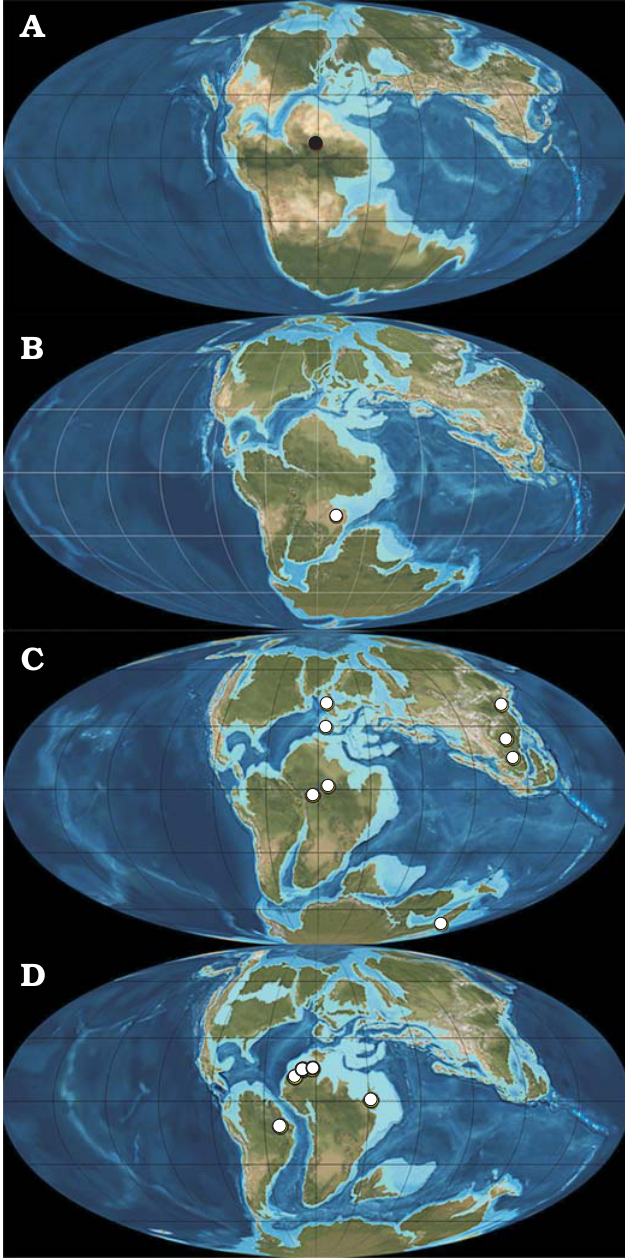
Fig. 6. Generalized palaeogeographic locations of spinosaurids (white) and the specimen of HB site (black), through time from Bajocian–Bathonian ( A ), Tithonian ( B ), Barremian − Aptian ( C ), and Albian − Cenomanian ( D ). Courtesy of Ron Blakey (http://jan.ucc.nau.edu/~rcb7/mollglobe.html), modified and actualized after Bertin